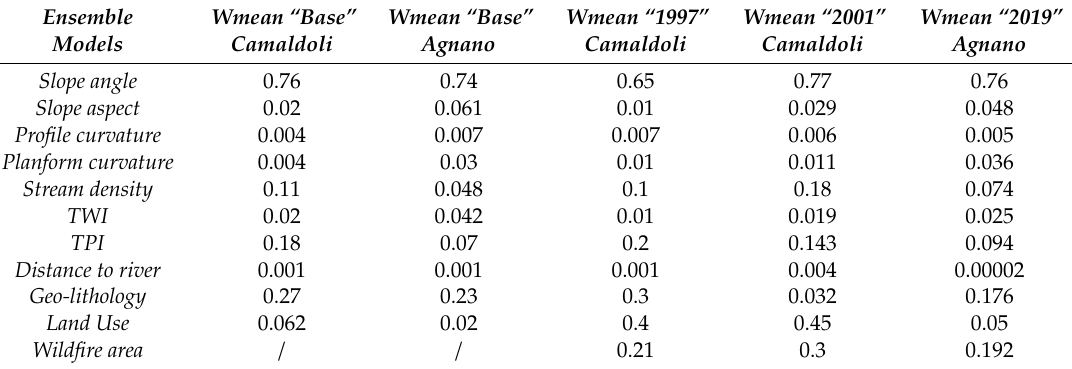
Table 7. Variables’ importance for the ensemble models. Green columns refer to the ensemble methods applied without the wildfire variable, blue columns also include the wildfire